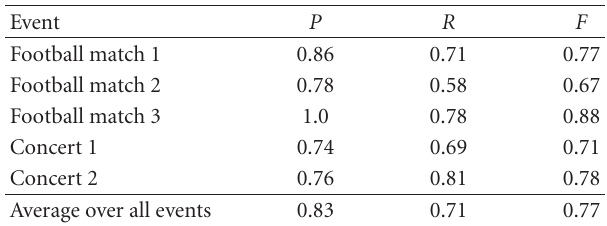
Table 7: Experimental results for detecting in-view cameras. P stands for Precision , R for Recall, and F for F-measure